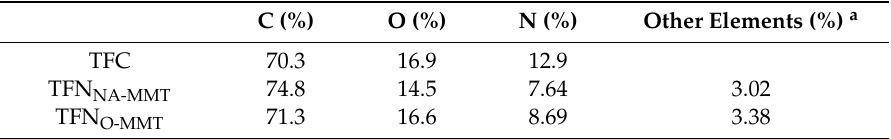
Table 1. Elemental composition of the membrane surface from XPS analysis.